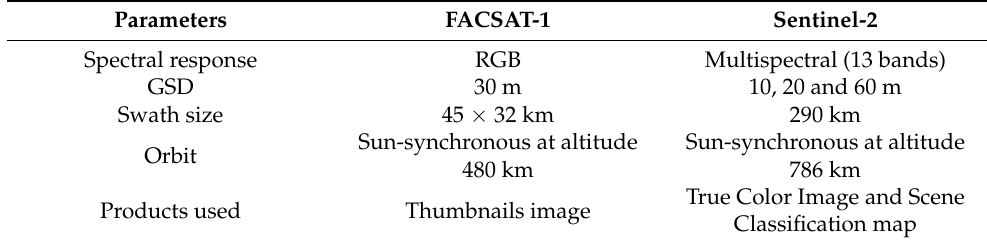
Table 3. Summary of FACSAT-1 and Sentinel-2